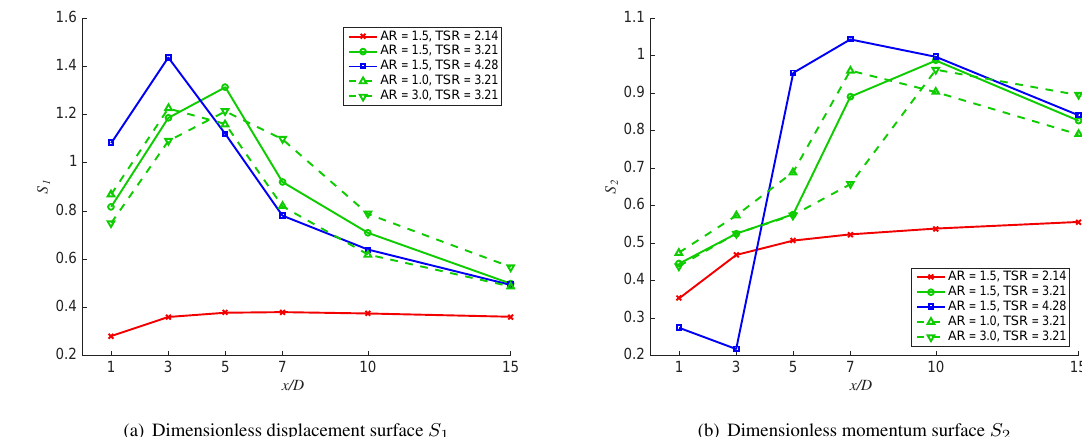
Figure 10. H-type VAWT: dimensionless displacement and momentum surfaces as functions of the streamwise coordinate.